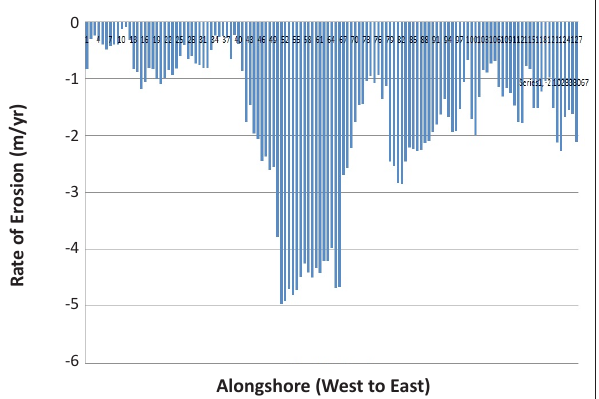
FIGURE 8: Erosion rates alongshore using the EPR